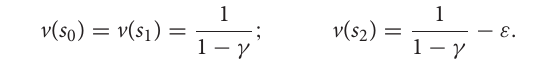
Lemma 1. For two complete demonstrations D 1 and D 2 and two arbitrary IRL agents A and